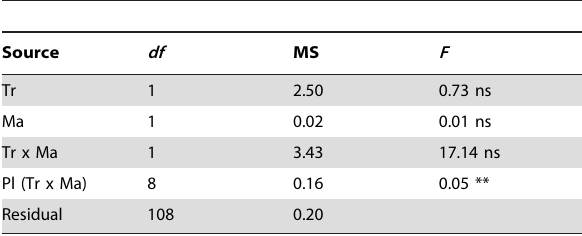
Table 6. Analysis of mean densities of chlorophyll- a for caged and uncaged treatments with limpets at natural densities (10S + 3L) at the end of the